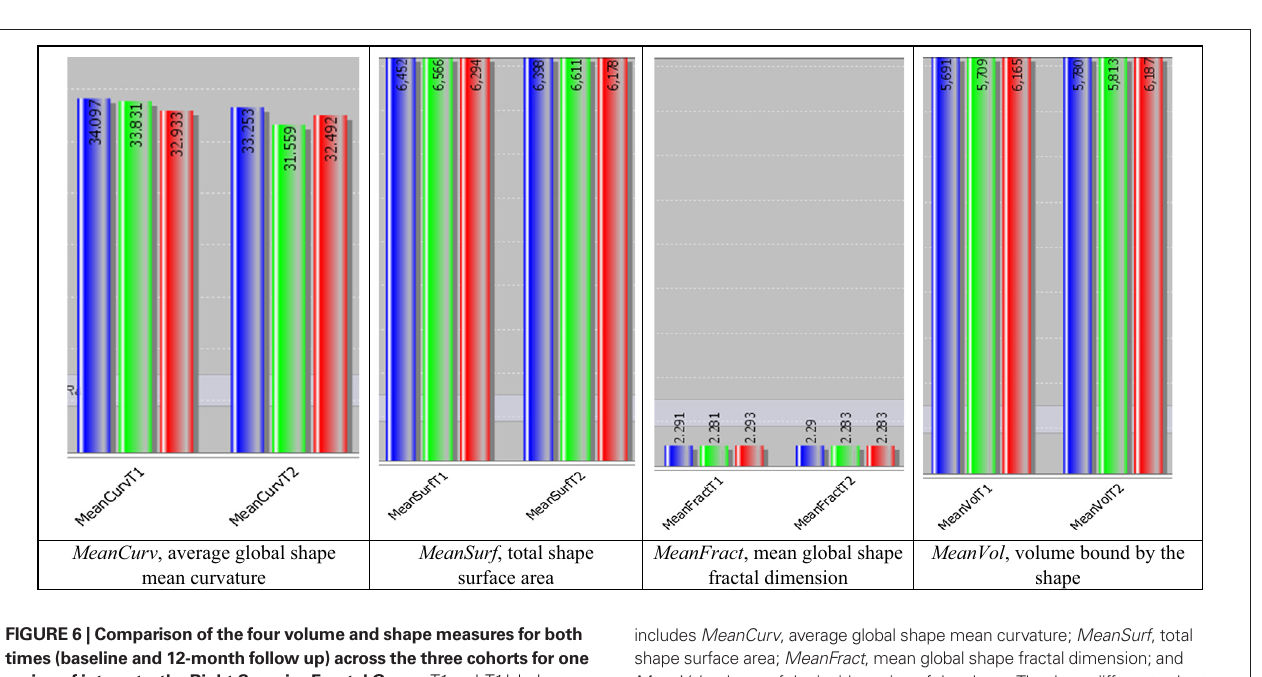
FIGURE 6 | Comparison of the four volume and shape measures for both times (baseline and 12-month follow up) across the three cohorts for one region of interest – the Right Superior Frontal Gyrus. T1 and T1 labels represent baseline and follow-up time scans. The statistics signature vector